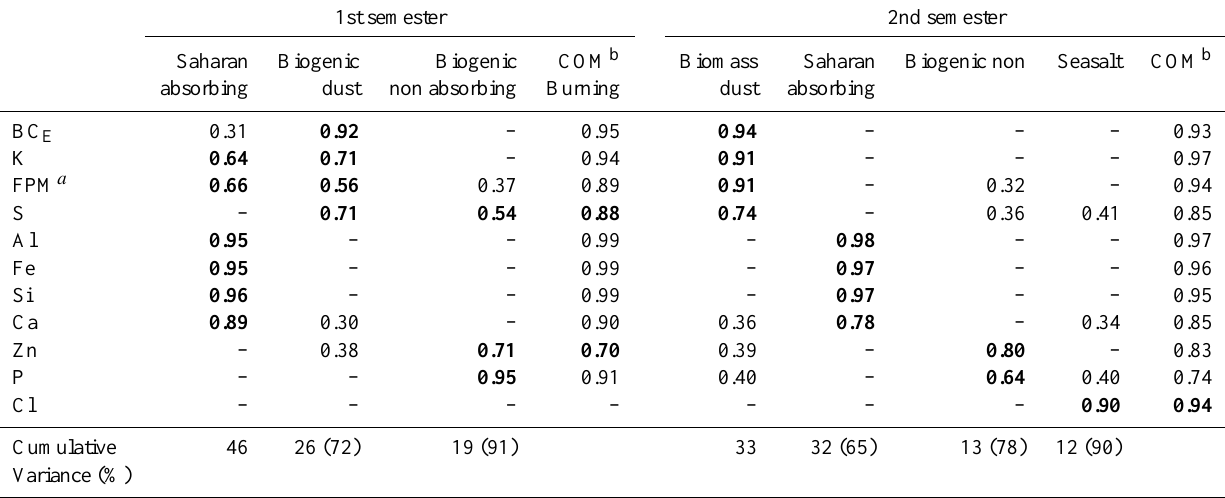
Table 2. Component loadings from the application of Principal Component Analysis for fine mode aerosol concentration data*. Results are shown separately for the 1st and 2nd semester. In the last line, it is shown the explained and cumulative (between brackets) variance for each extracted component. Chlorine was not included in the wet season analysis due to insufficient samples above detection limits to perform component